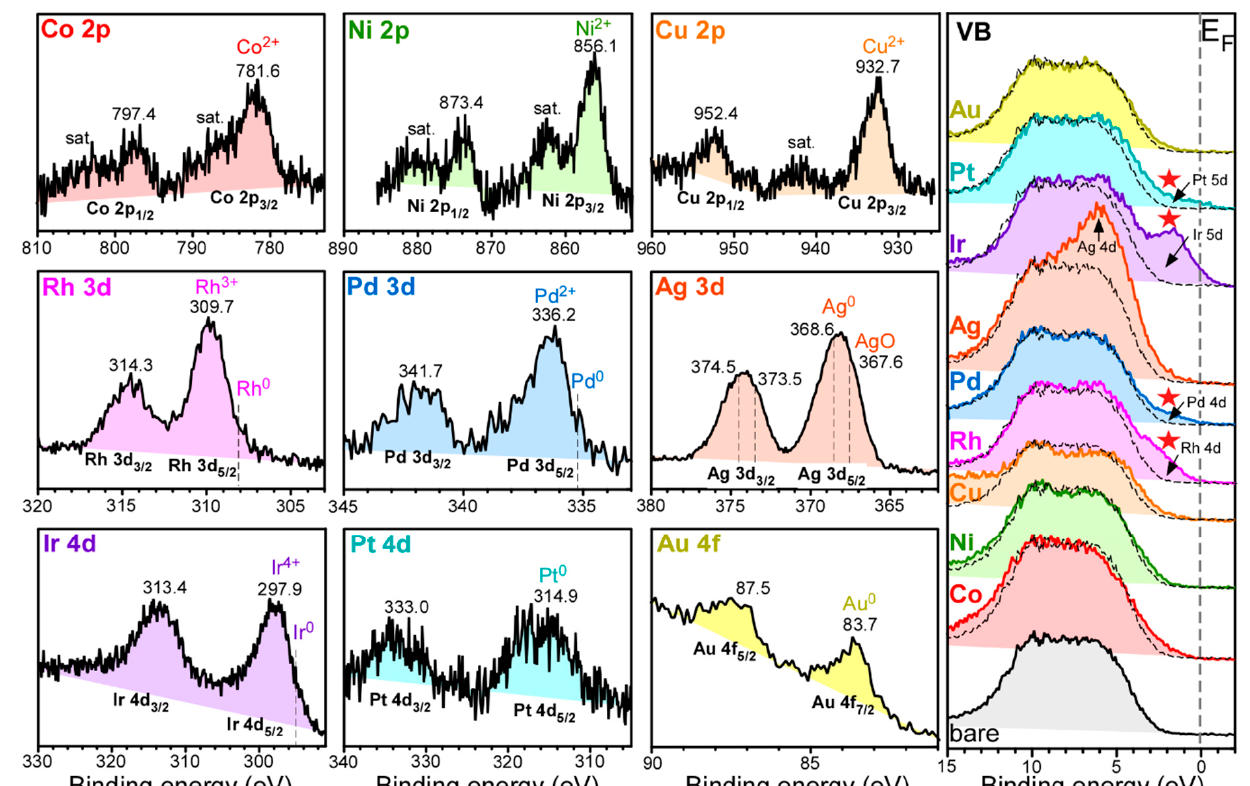
Figure 4. Co 2p, Ni 2p, Cu 2p, Rh 3d, Pd 3d, Ag 3d, Ir 4d, Pt 4d, Au 4d, and VB profiles of Co-Al 2 O 3 , Ni-Al 2 O 3 , Cu-Al 2 O 3 , Rh-Al 2 O 3 , Pd-Al 2 O 3 , Ag-Al 2 O 3 , Ir-Al 2 O 3 , Pt-Al 2 O 3 , and Au-Al 2 O 3 nanosheets.